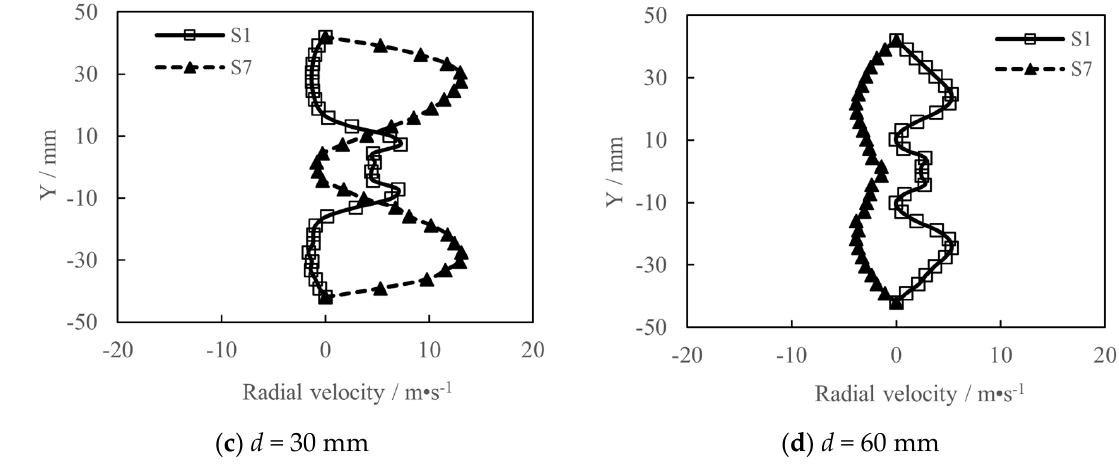
Figure 20. Radial profiles of radial velocity.